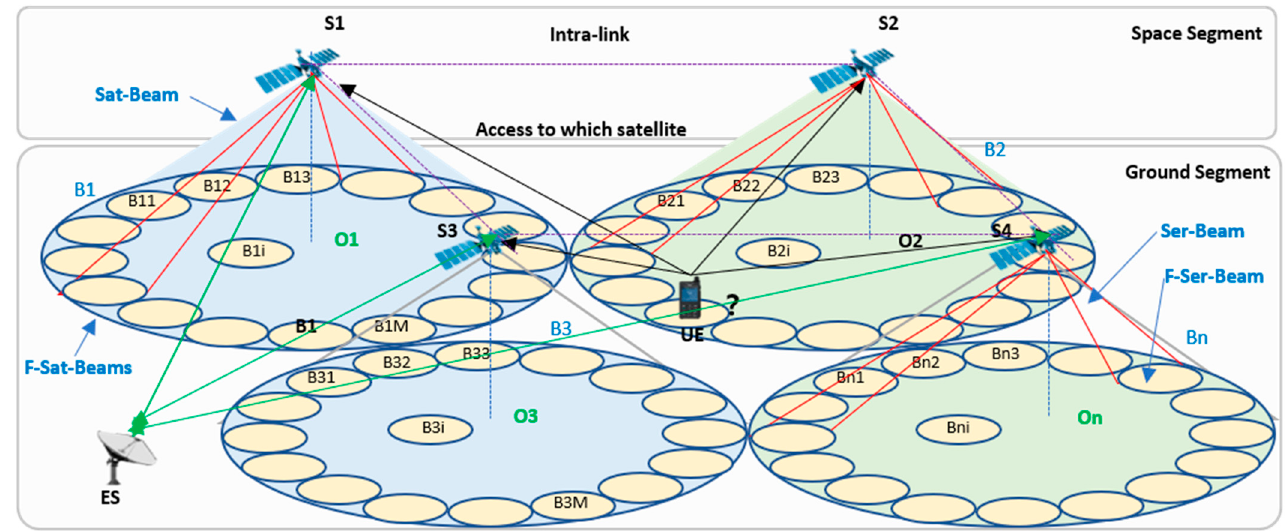
Figure 2. The network framework of S-IoT-N.